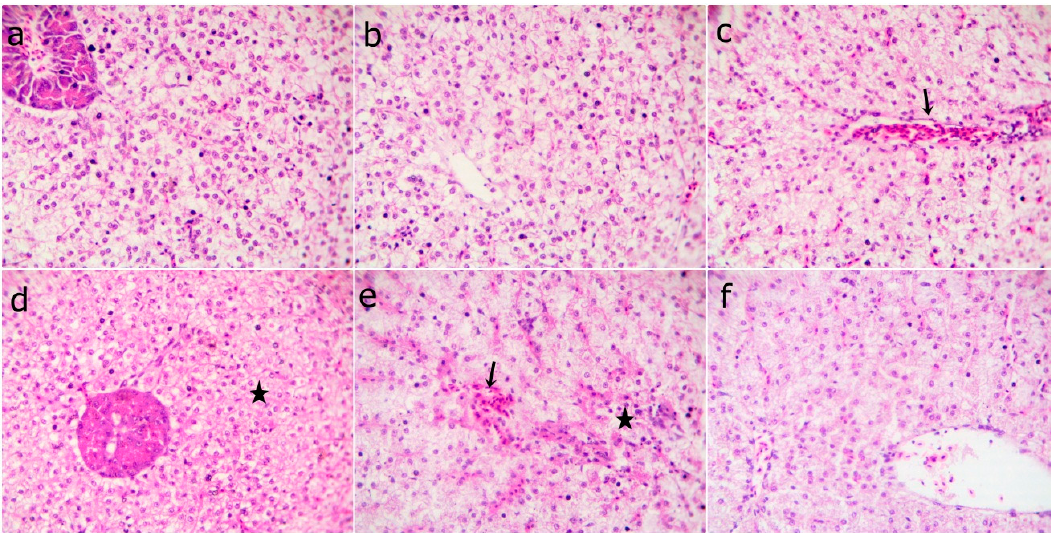
Figure 5 Representative photomicrograph of the H&E stained sections from fish liver after bacterial challenge showing ( a ) WPC0—normal histomorphological structures at 400x; ( b ) WPC13.8—normal central vein and hepatocytes at 400x; ( c , WPC27.7) markedly congested hepatic blood vessels (arrow)